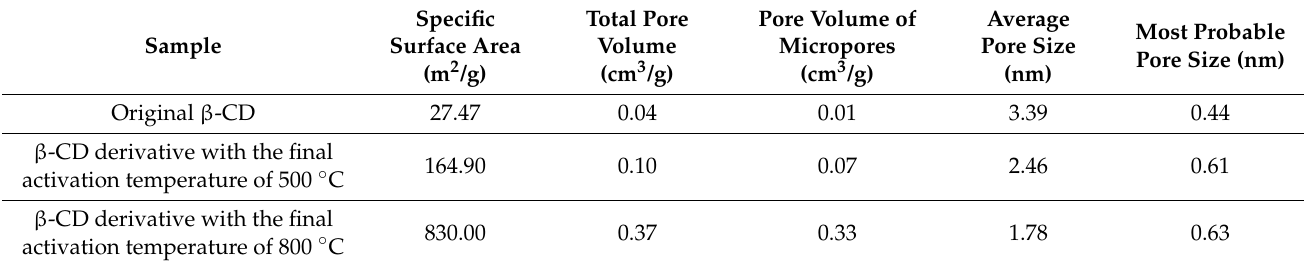
Table 4. Pore structural characteristics of β -CD sample before and after